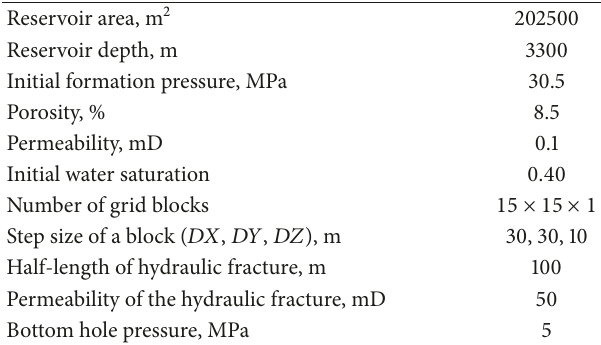
Table 1: Basic model parameters.